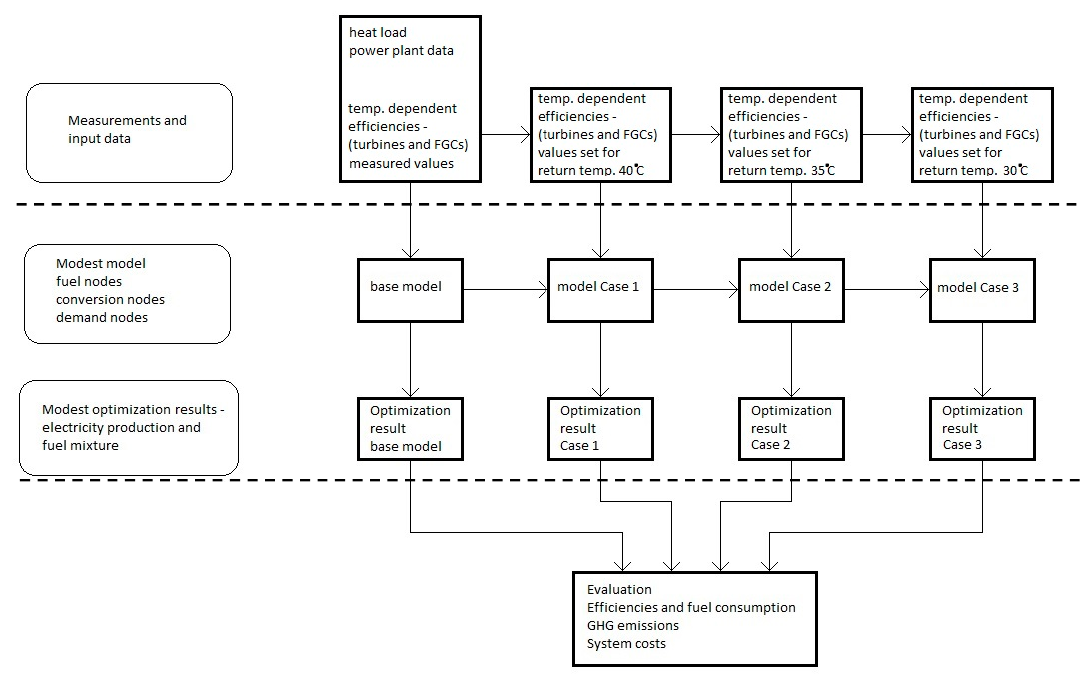
Figure 4. Schematic illustration of the workflow for the study. Horizontal lines show borders for the Model for Optimization of Dynamic Energy Systems with Time-dependent components and boundary conditions (MODEST) model.